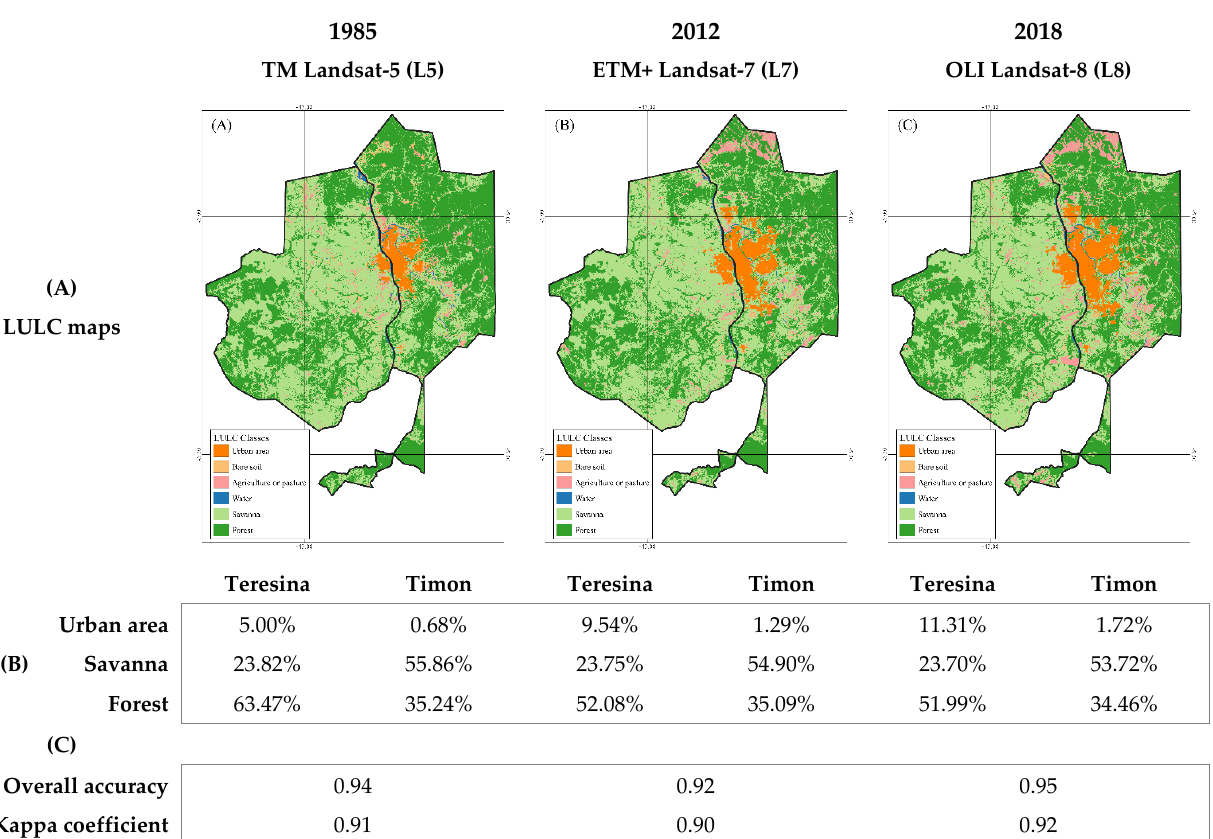
Figure 4. ( A ) TM (L5), ETM+ (L7), and OLI (L8) LULC maps from 1985, 2012, and 2018, respectively. ( B ) The proportion of LULC thematic classes: Urban area, Savanna, and Forest in Teresina and Timon municipalities. ( C ) Overall accuracy (OA) and Kappa coefficient (KC) of each LULC classification.